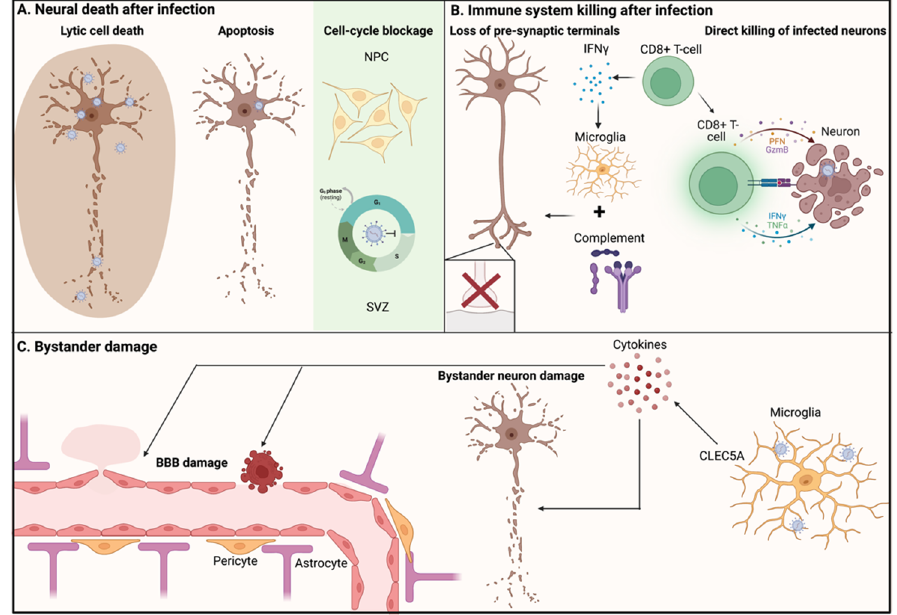
Figure 5. Mechanisms of neuropathogenesis by Flaviviruses. Legend: NPC = neuroprogenitor cell, SVZ = Subventricular zone, BBB damage = blood–brain-barrier damage, IFN γ = Interferon γ , CLEC5A = C ‐ type lectin member 5A. Created in Biorender.